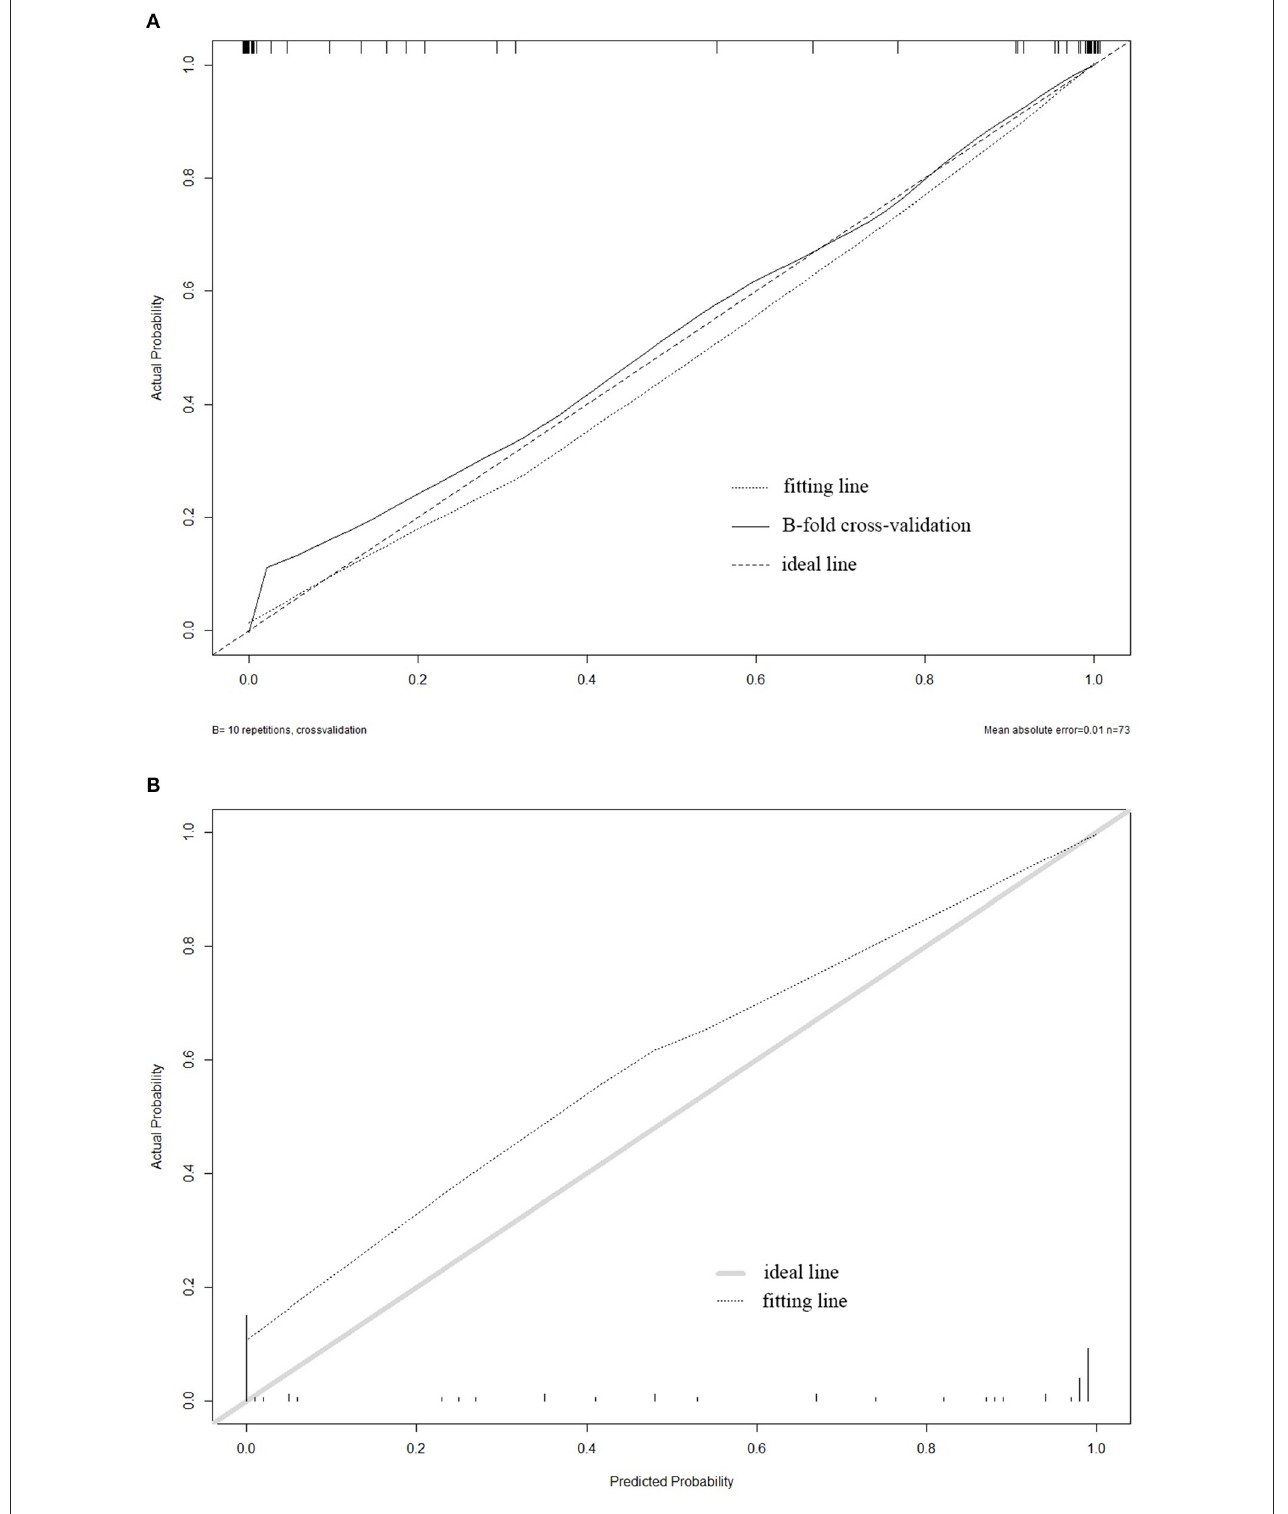
FIGURE 3 | (A) The Calibration Curve of the training set. (B) The Calibration Curve of the validation set. The abscissa of the graph is the predicted probability, and the ordinate is the actual probability. The ideal line indicates that the actual probability and the predicted probability are perfectly coincident under an ideal situation. The fitting line represents the predicted probability corresponding to the actual probability. If the predicted probability is greater than the actual probability, that is, the risk is